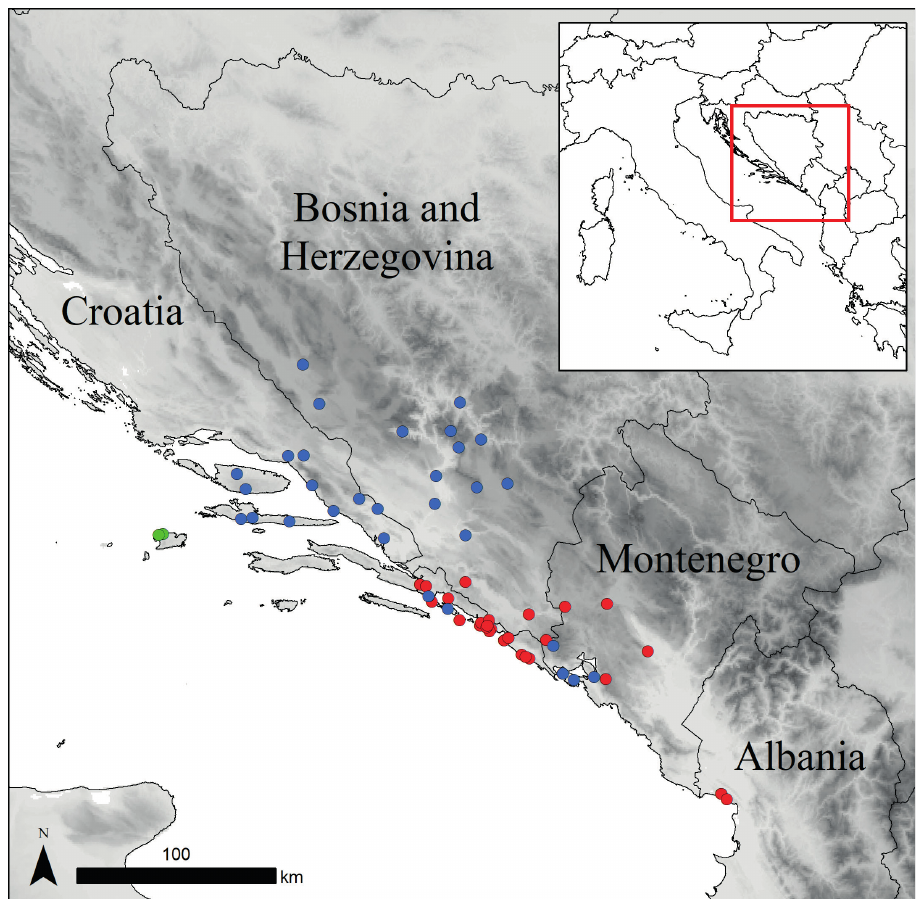
Figure 4. Distribution of Centaurea lovricii sp. nov. (green dots), C. glaberrima (red dots) and C. divergens (blue 2. Centaurea glaberrima Tausch, Syll. Pl. Nov. 2: 249, 1828. Figs 5, 6 Centaurea punctata Vis., Flora 12: 23, 1829. Type: Croatia. In agris sterilibus Dalm. [Dalmatia] montanae (prope Duare), Visiani s.n. (lectotype, designated here: PAD – HD02644).